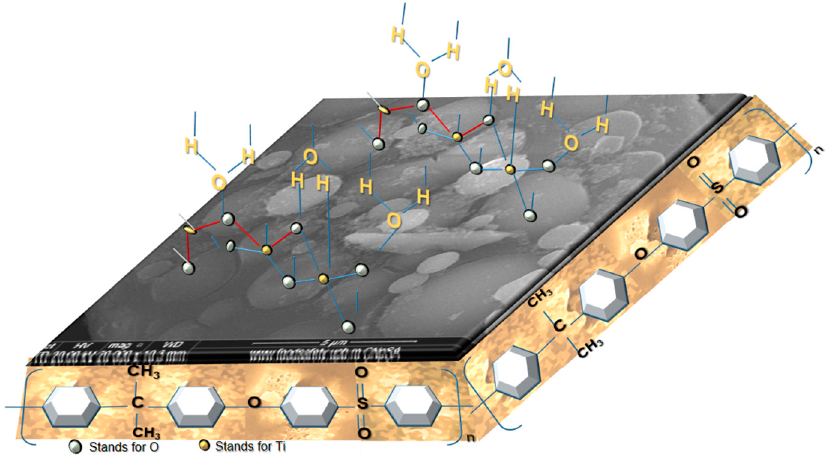
Figure 12. Schematic representation of the polysulfone composite membrane highlighting the hydrophilic surface.